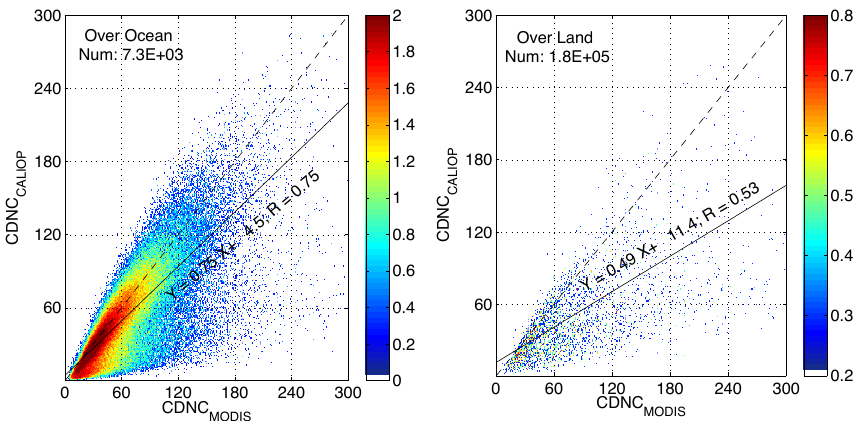
Figure 3. Relationship between the MODIS and CALIOP CDNCs over ocean (a) and over land (b) . The dashed line is the x = y line ( x : MODIS CDNC; y : CALIOP CDNC), and the solid line is the CDNC linear regression line. The color bar represents the logarithm of the pixel number. “Num” represents pixel number and “ R ” is the correlation coefficient of the linear relationship of the two